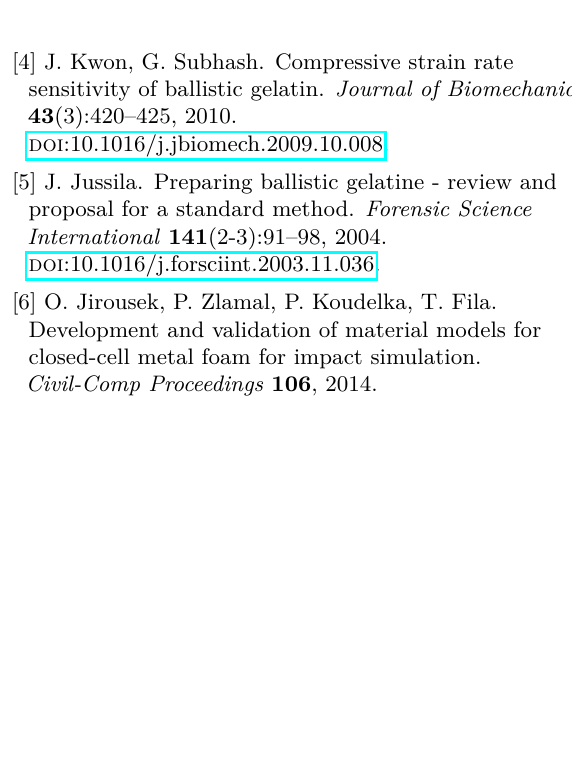
Figure 6. Loading scene of selected sample (group A3) in several loading steps (time step between captured images is